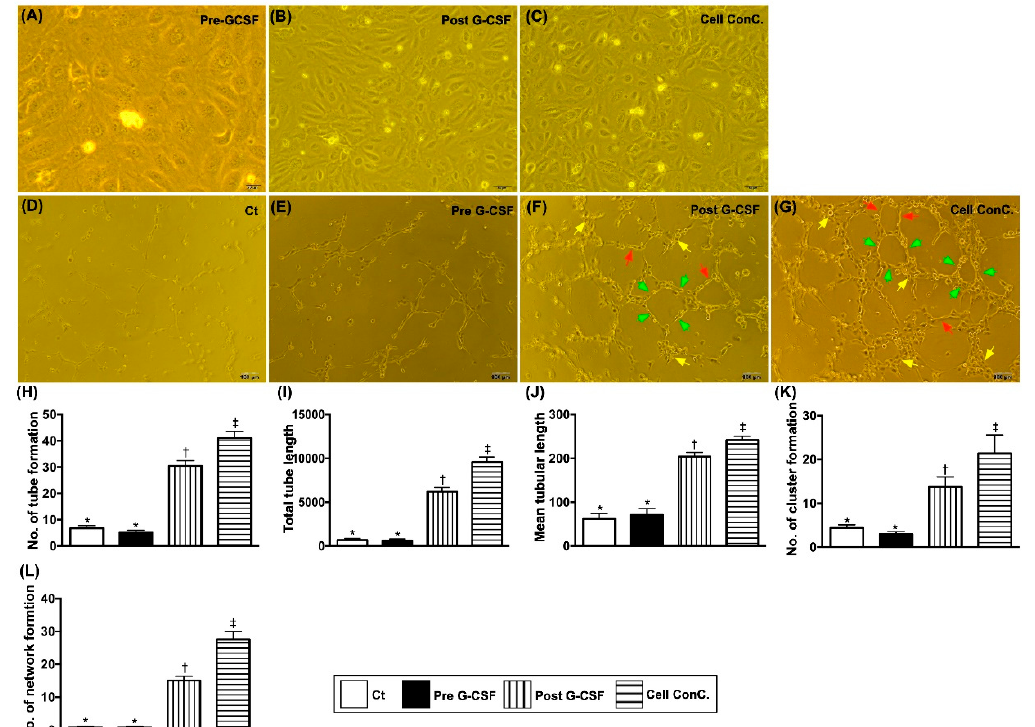
Figure 5. Morphological feature of EPCs and Matrigel assay for assessment of angiogenesis. ( A – C ) Illustrating the microscopic finding (200x) of morphological feature of 21-day culturing endothelial progenitor cells (EPCs), i.e., cobblestone-like morphology of typical endothelial cells. Scale bars in the right lower corner represent 50 µ m. ( D – G ) Illustrating the pictures of Matrigel assay. Red arrows indicated tubular formation; yellow arrows indicated cluster formation; green arrows indicated network formation. ( H ) Analytical result for number of tubule formation, * vs. other groups with di ff erent symbols ( † , ‡ ), p < 0.0001. ( I ) Analytical result of total tubular length, * vs. other groups with di ff erent symbols ( † , ‡ ), p < 0.0001. ( J ) Analytical result of mean tubular length, * vs. other groups with di ff erent symbols ( † , ‡ ), p < 0.0001. ( K ) Analytical result of number of cluster formation, * vs. other groups with di ff erent symbols ( † , ‡ ), p < 0.0001. ( L ) Analytical result of number of network formation, * vs. other groups with di ff erent symbols ( † , ‡ ), p < 0.0001. All statistical analyses were performed by one-way ANOVA, followed by Bonferroni multiple comparison post hoc test ( n = 30 for each group). Symbols (*, † , ‡ ) indicate significance (at 0.05 level). Clt = control group; pre-G-CSF = the study group prior to G-CSF treatment; post G-CSF = indicated the study group of post G-CSF treatment; G-CSF = granulocyte-colony stimulating factor; No. = number.